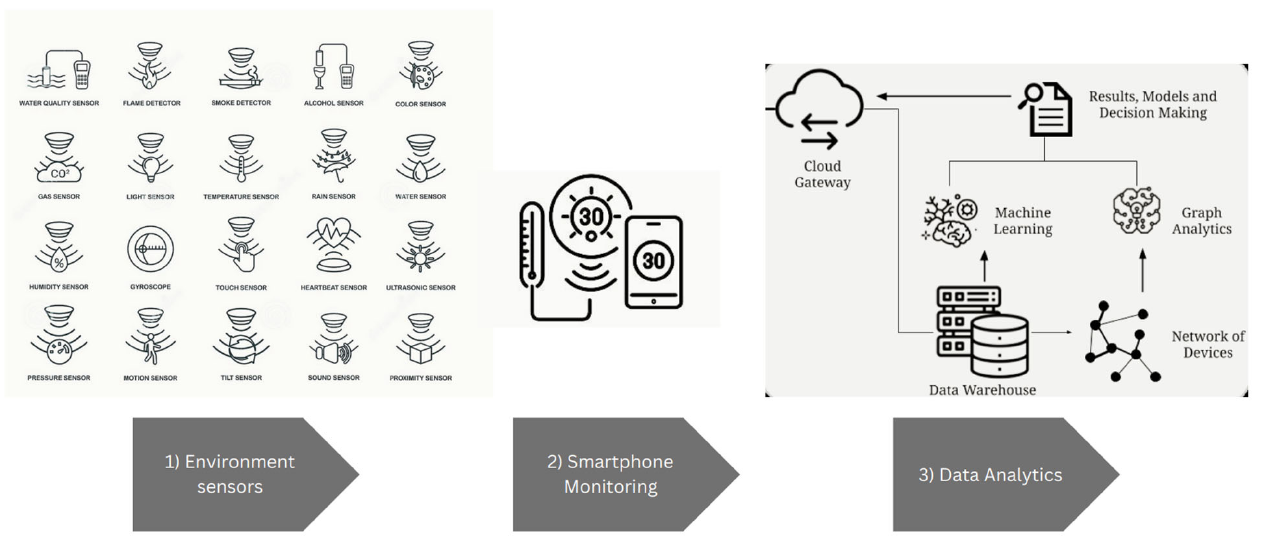
Figure 6. Smartphone for monitoring.